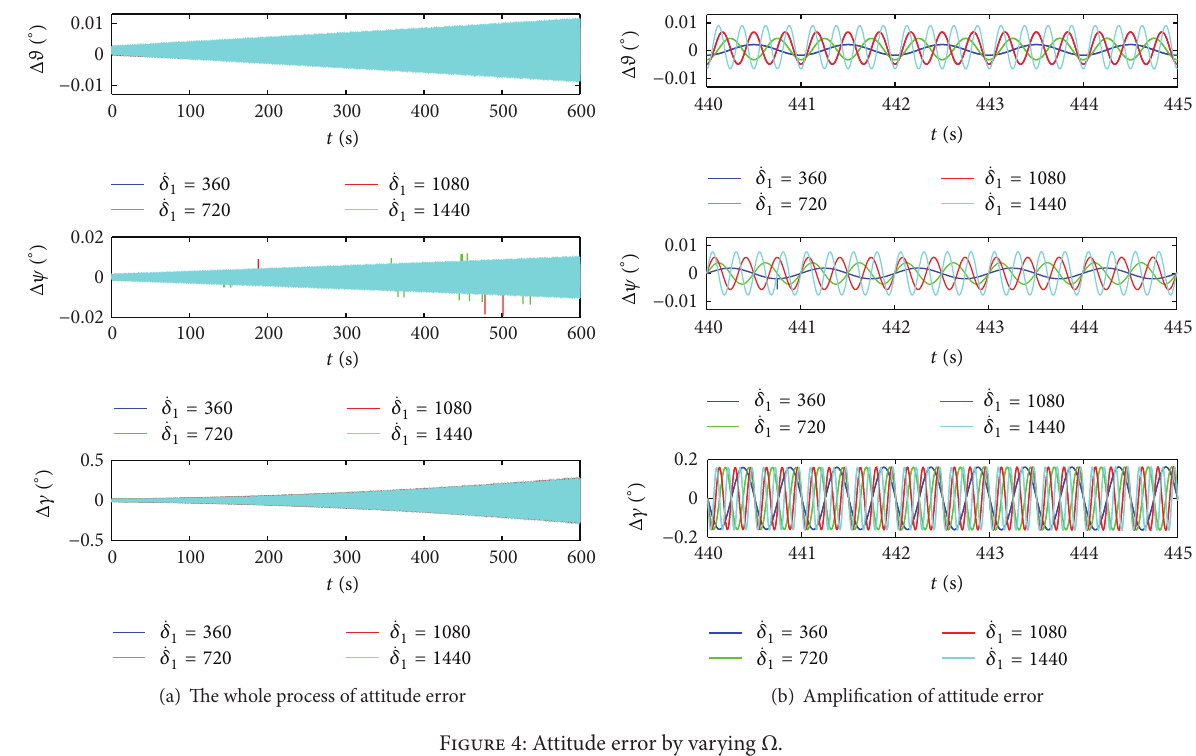
Figure 4: Attitude error by varying Ω .